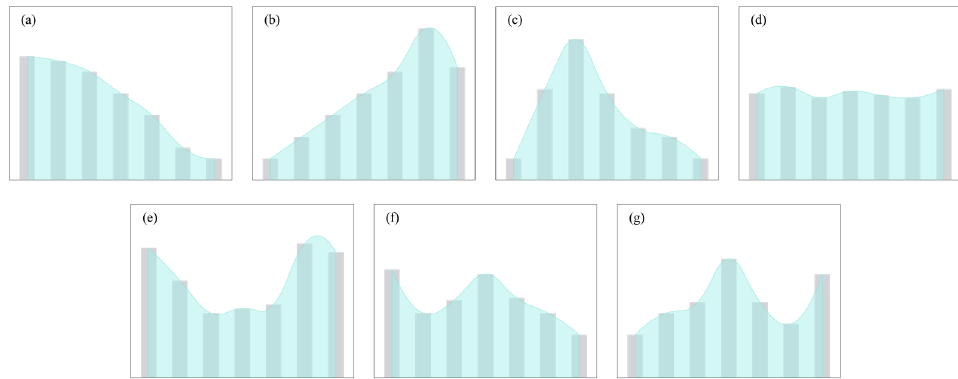
Figure 1. The seven types of rainfall patterns are ( a ) the first kind pattern, ( b ) the second kind pattern, ( c ) the third kind pattern, ( d ) the fourth kind pattern, ( e ) the fifth kind pattern, ( f ) the sixth kind pattern, and ( g ) the seventh kind pattern defined by Molokov [34].